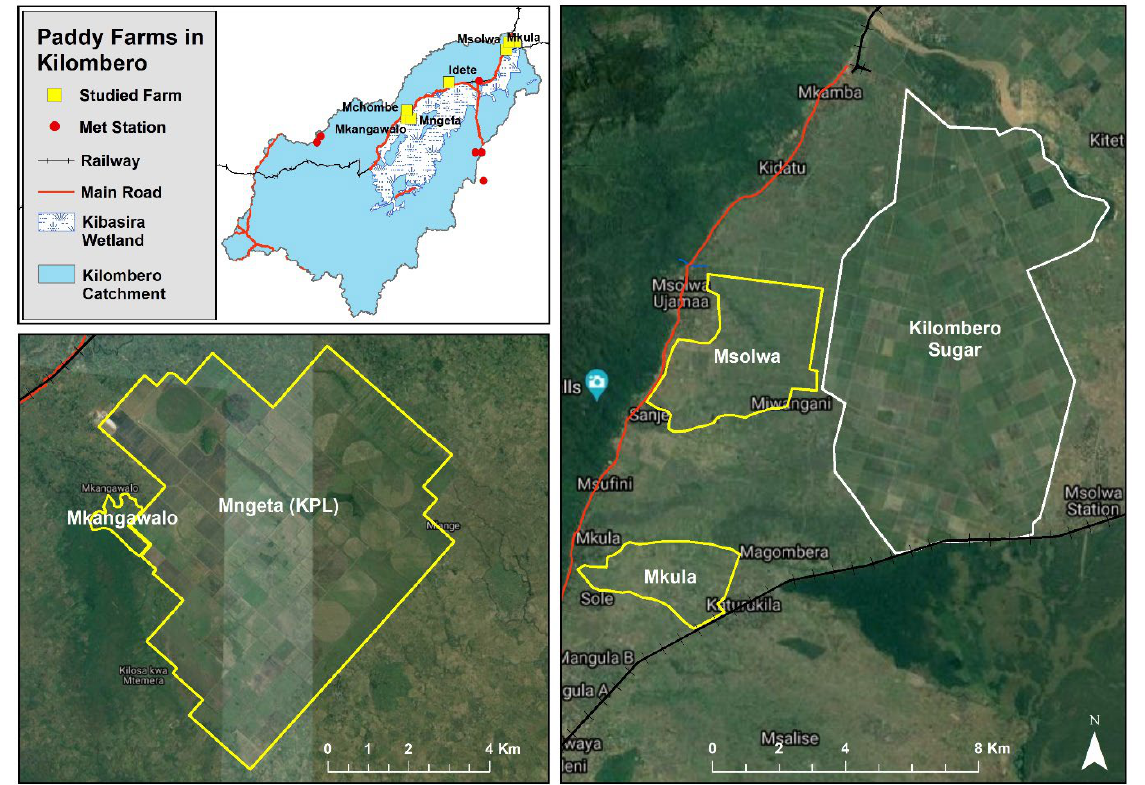
Figure 5. The spatial illustration of some of the sampled farms in the study area. Map shows only those large enough for illustration. those large enough for